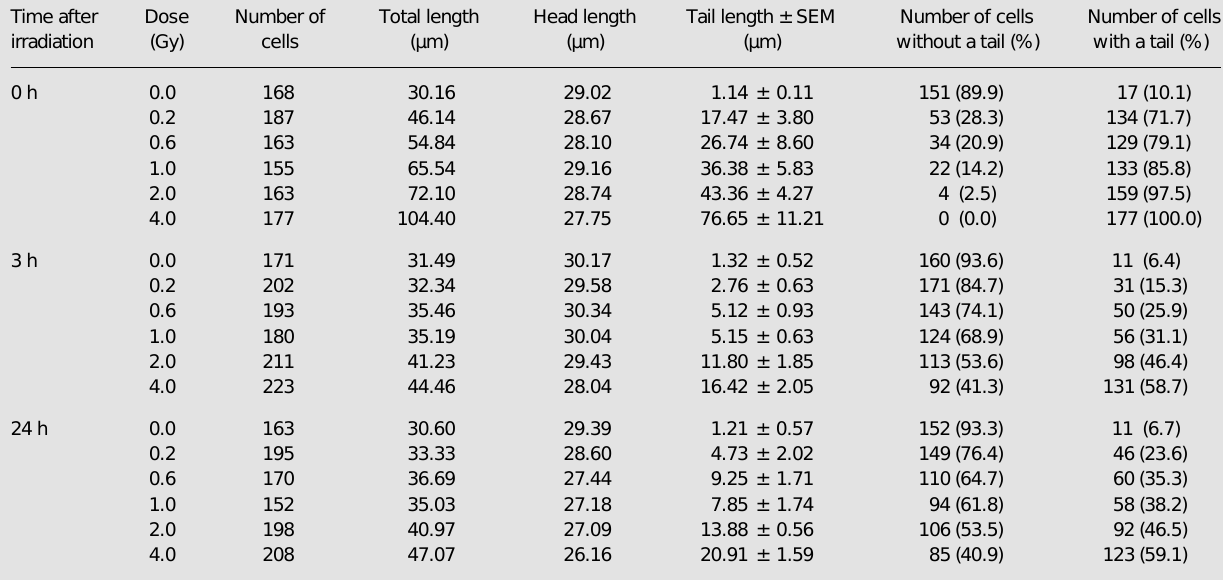
Table 2 - Mean values of comet length (head and tail) obtained for blood samples from 3 healthy donors, processed immediately or 3 and 24 h after in vitro exposure to 60 Co. Tail length = Total length - head length.